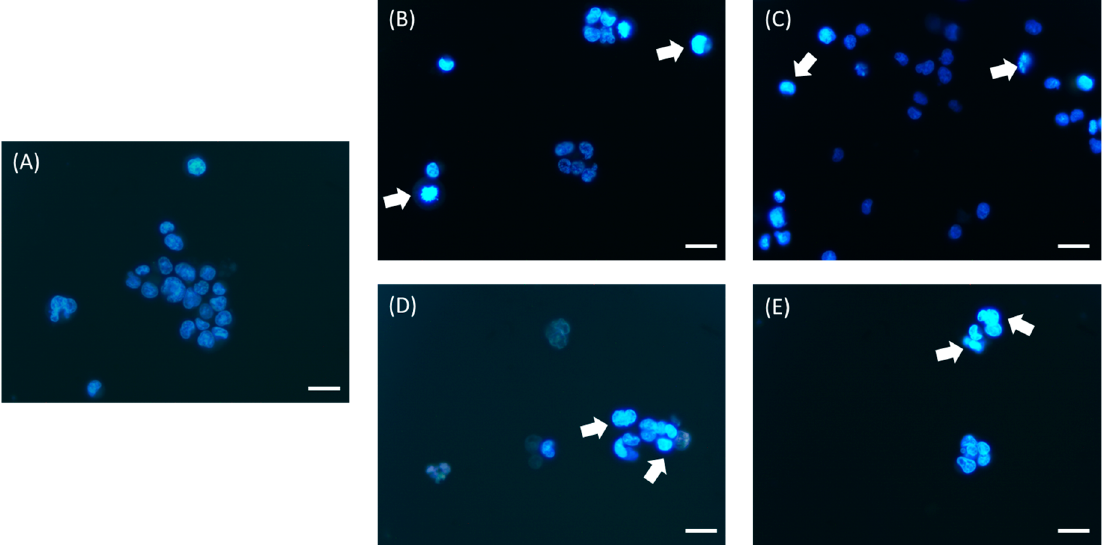
Figure 12. Representative images (40×) of morphological changes of nuclear chromatin in HepG2 cells stained with Hoechst 33,342 and ethidium bromide. Cells were plated in the absence ( A ) or the presence of etoposide (50 µM) ( B ), sample 10 (CH+10PR, 25 mg/mL) ( C ), sample 14 (CH+10RJ+10PR, 10 mg/mL) ( D ), and sample 16 (PR, 25 mg/mL) ( E ) for 48 h. White arrows indicate apoptotic cells. Scale bar = 50 µm.